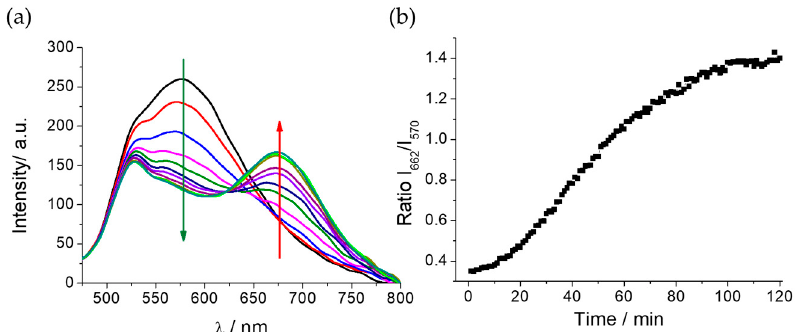
Figure 3. ( a ) Evolution of the emission spectra of DCM-HBU (25 μ M) with TYR (0.13 mg mL − 1 ) observed every 10 min for 2 h by excitation at 450 nm at 37 °C; and ( b ) Ratiometric measurements of fluorescence signals of I 662/ I 570 at different times.